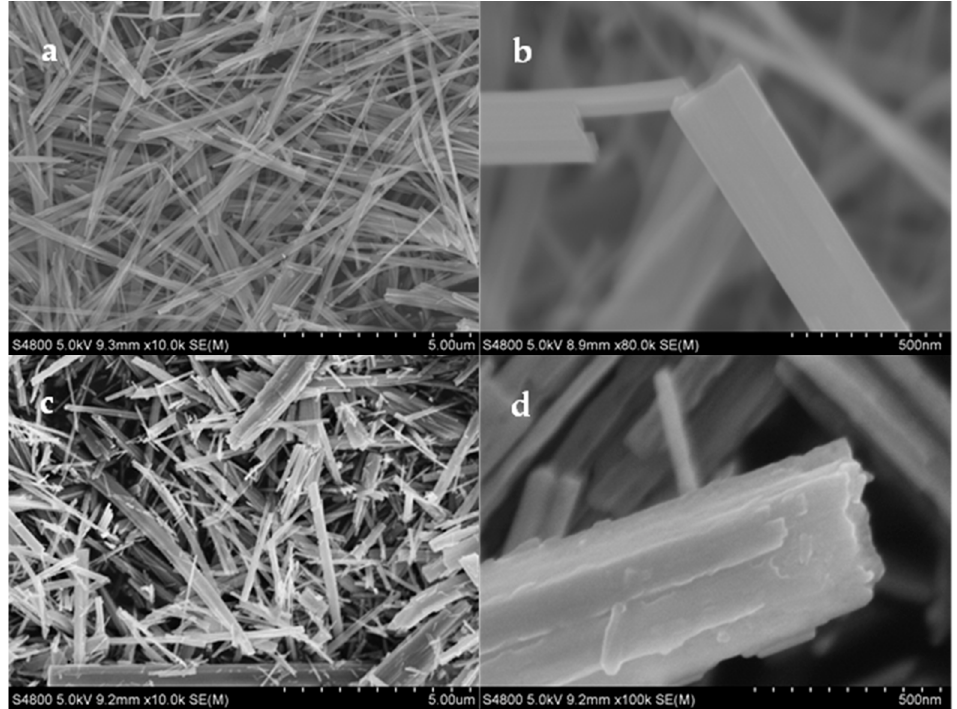
Figure 2. Representative SEM micrographs of ( a , b ) TiO 2 and ( c , d ) Ho 2 O 3 -TiO 2 nanobelts.